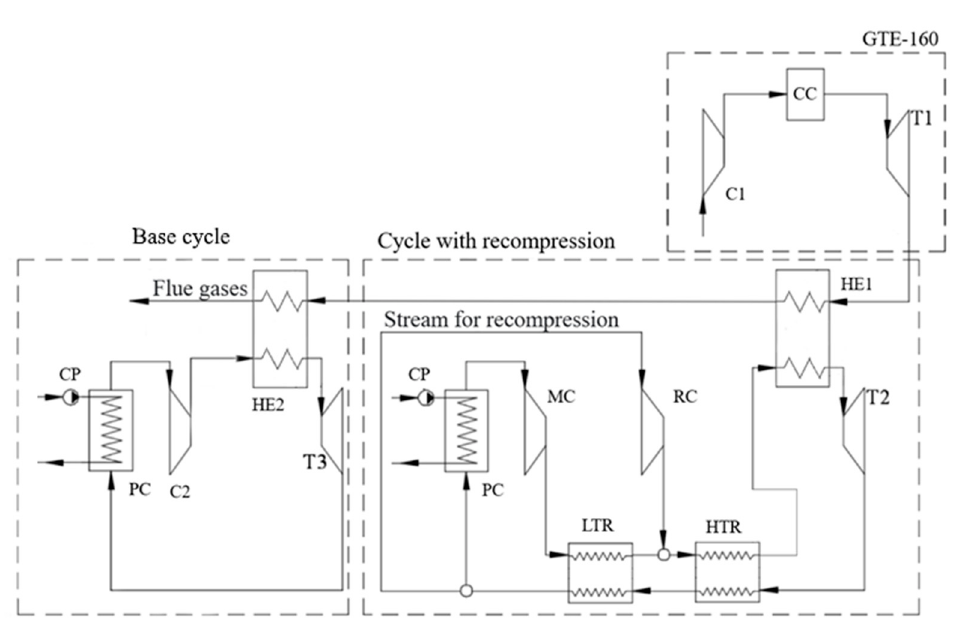
Figure 2. Combined Recompression & base version S-CO 2 Brayton cycle.